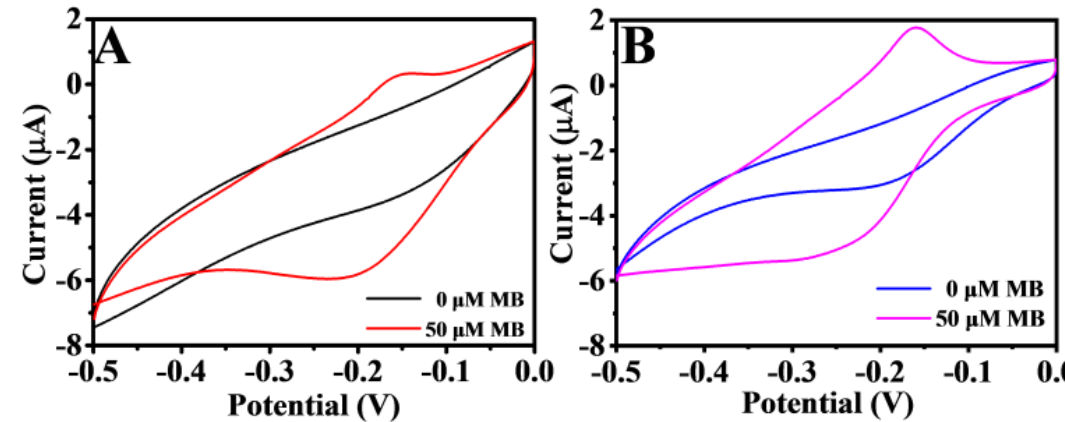
Figure 4. CV of Au/GCE ( A ) and Au/NiFe-LDH/GCE ( B ) in 10 mM PBS (pH 7.0) with 0 and 50 µ M MB, respectively. Scan rate: 100 mV/s.